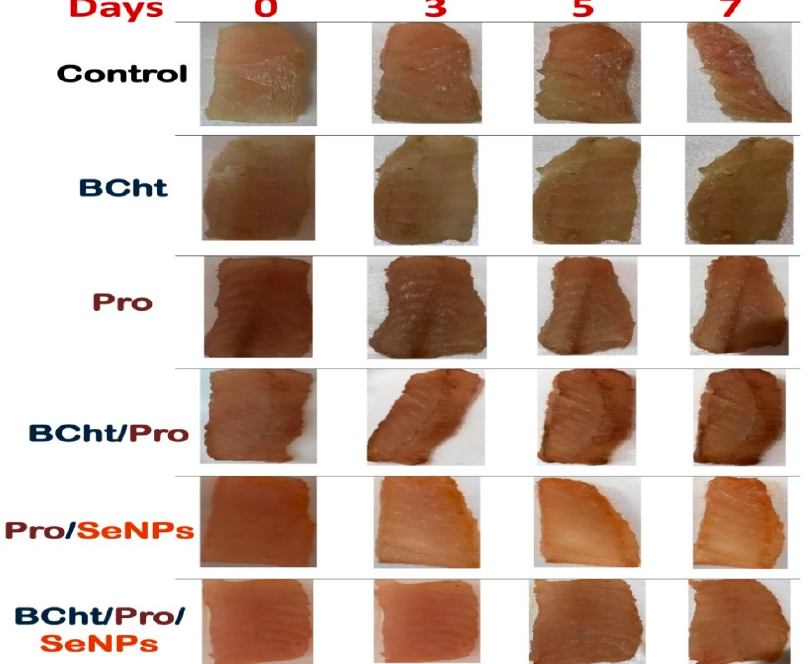
Figure 6. Manifestations of coated catfish fillets with bee chitosan nanoparticles (BCht), propolis (Pro), Pro with BCht, Pro with synthesized SeNPs (Pro/SeNPs) and BCht/Pro/SeNPs nanocomposite, compared to water-dipped (Control) samples, during cold storage for 7 days at 4 °C .